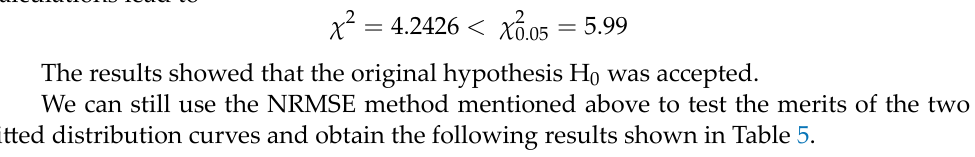
Table 5. NRMSE results. Parameter Estimation